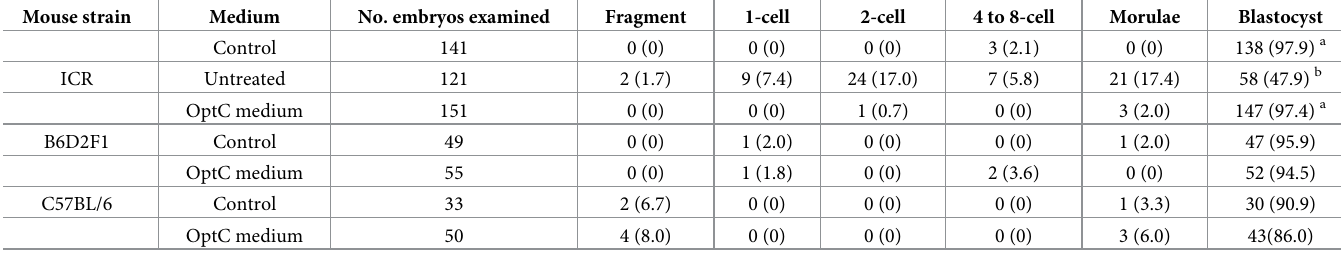
Table 1. Blastocyst development of embryos cultured in a sealed tube with OptC